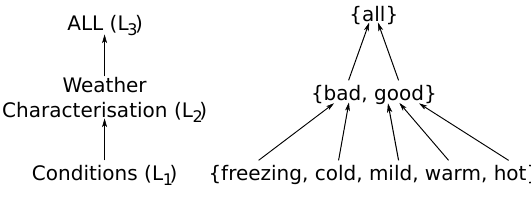
Fig. 3. Extended domain of weather